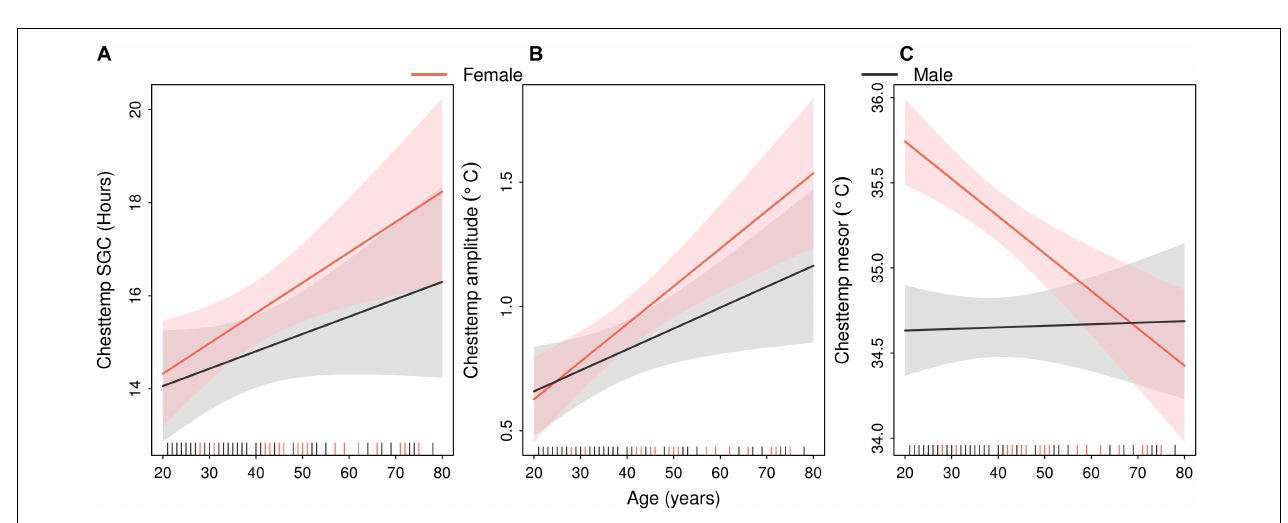
FIGURE 5 | Sex-specific linear relations between age and Chesttemp circadian parameters. Estimated regression lines (solid lines) with 90% confidence bands (shaded areas) in males (black) or females (red). The vertical dashes in the abscissa indicate the age of each of the 88 subjects in both STs. (A) Chesttemp SGC, (B) Chesttemp amplitude, and (C) Chesttemp